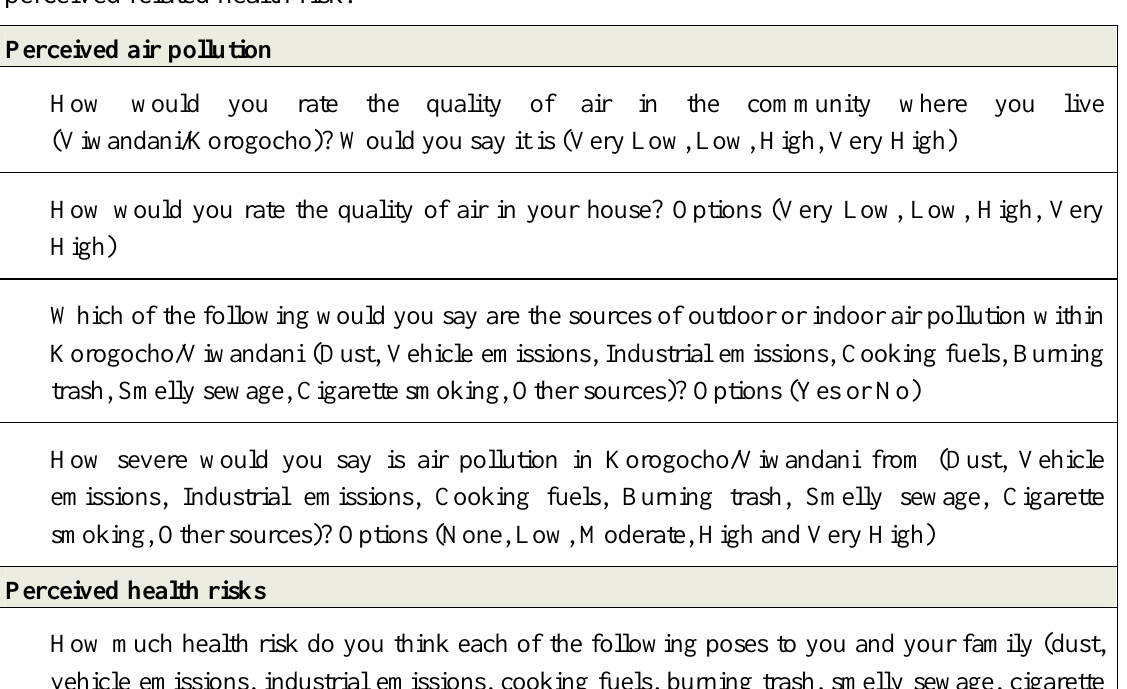
Table 1. List of questions for the composite indices of perceived level of pollution and perceived related health